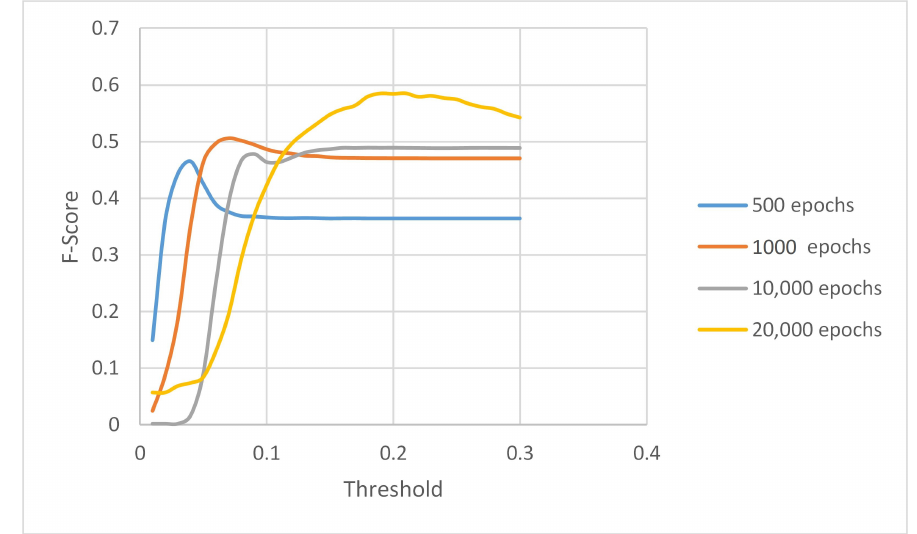
Figure 13. F-score evolution according to the threshold. This test was performed for several sets of